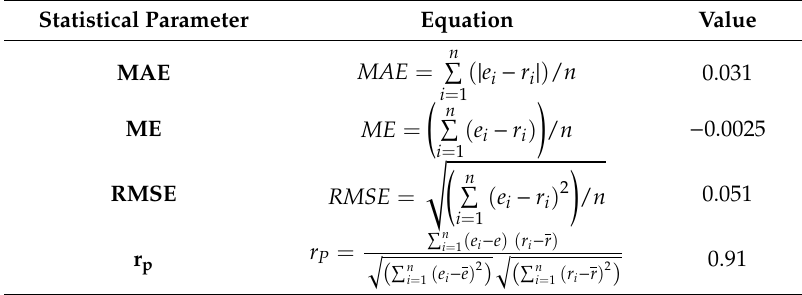
Table 1. The equations and computed values of four basic statistical parameters calculated from the comparison between the ANN (algorithm theoretical estimations) and measured daily AOD 550 nm values (in the equations e refers to the theoretical estimates, r to the real values, and n is the total number of the values of the validation sample). MAE: mean absolute error; ME: mean error; RMSE: root mean squared error; and r p : Pearson correlation. Statistical